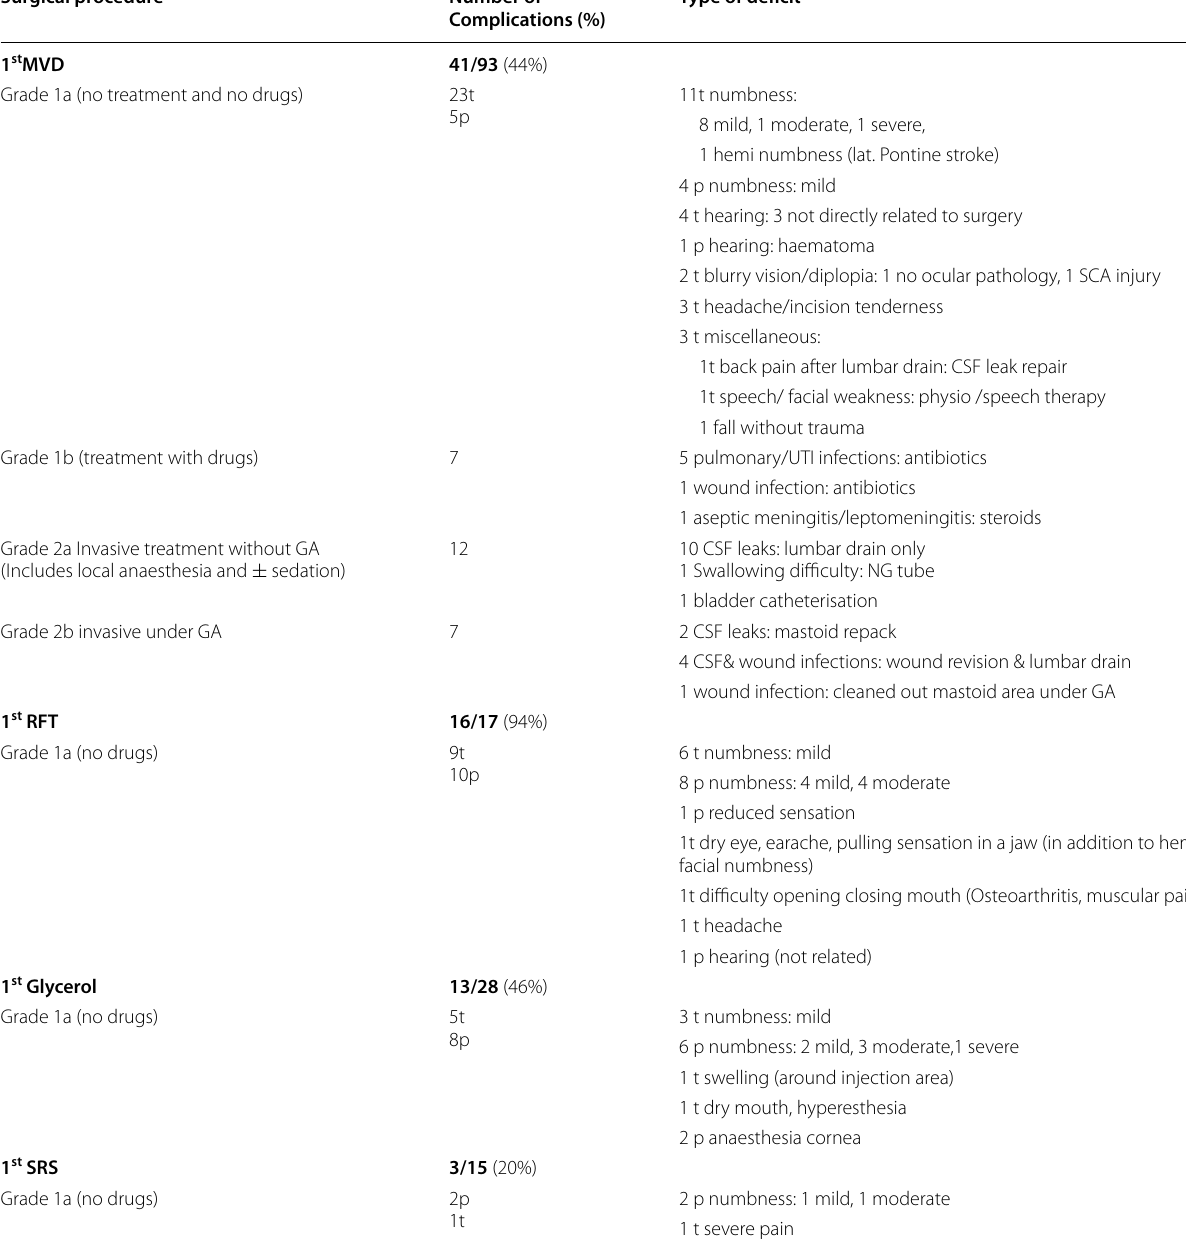
Table 4 Complications after first surgery Surgical